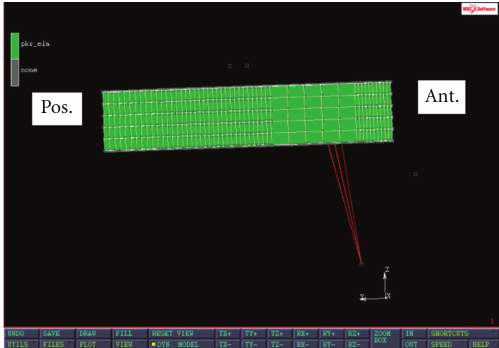
Figure 2: Sagittal view of a modified PKR model with a superior screw design. Red lines in the FE model are RBE2 nodal ties representing a superior screw.